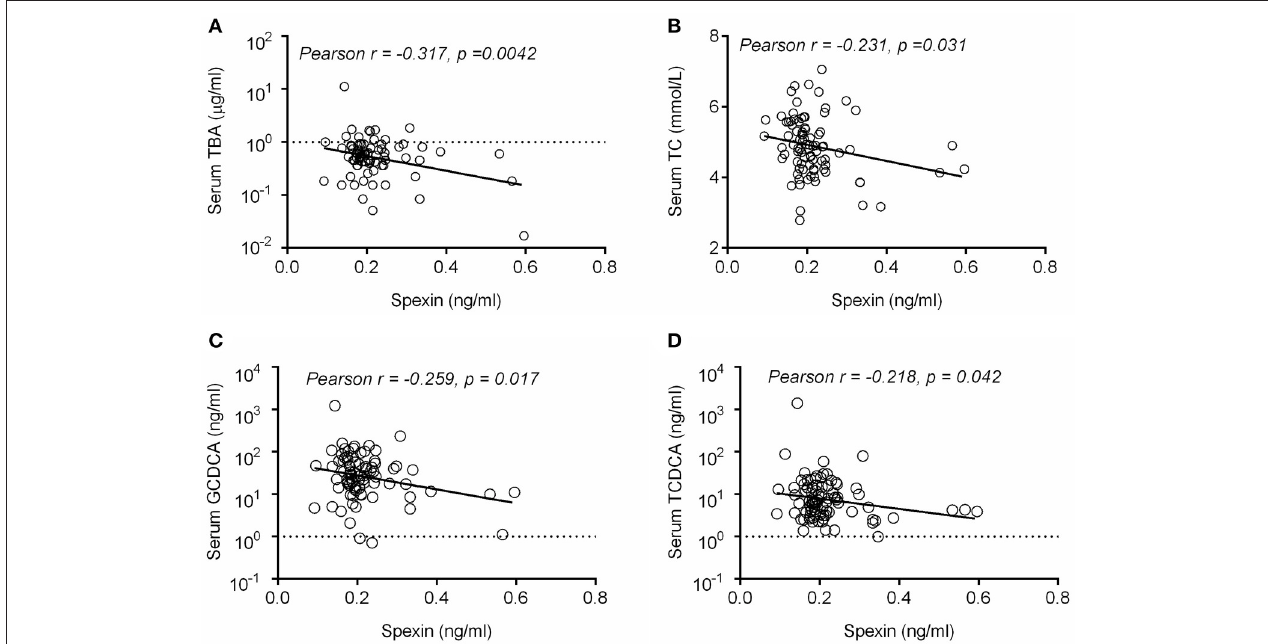
FIGURE 7 | Serum spexin and bile acid levels were negatively correlated in healthy volunteers. Correlation analysis of serum spexin with serum TBA (A) , serum TC (B) , serum GCDCA (C) , and serum TCDCA (D) were performed in this study using GraphPad Prism 5.0 software. The data was plotted in a scatter chart with linear regression fit and the respective Pearson correlation coefficients and the p- value were calculatí.